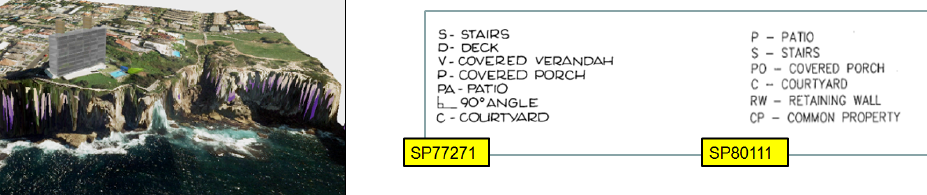
Figure 12: Acronym difference across different